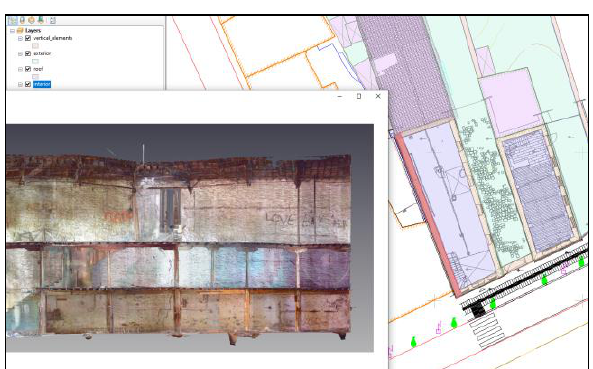
Figure 17 . The GIS application (linkage of features classes with laser scanner data).